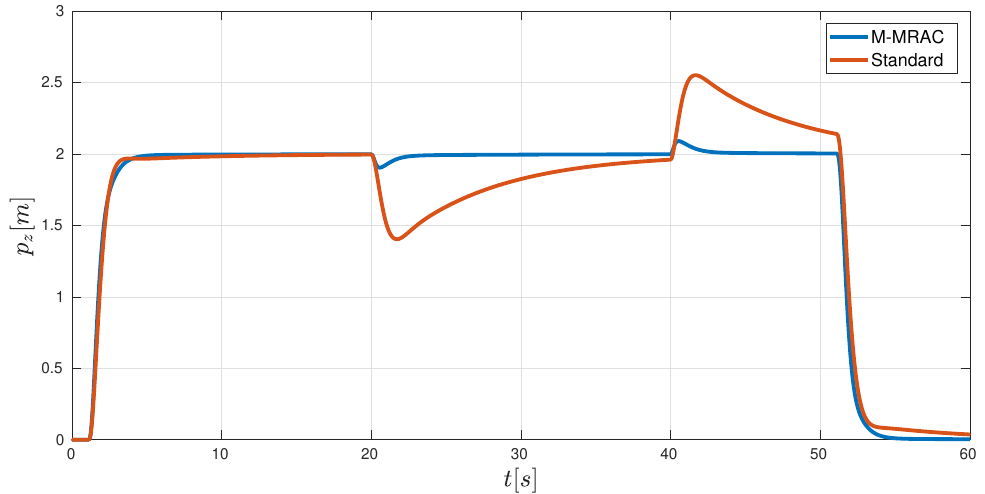
Figure 4. Simulation of the UAV performing a position-controlled flight whilst changing the